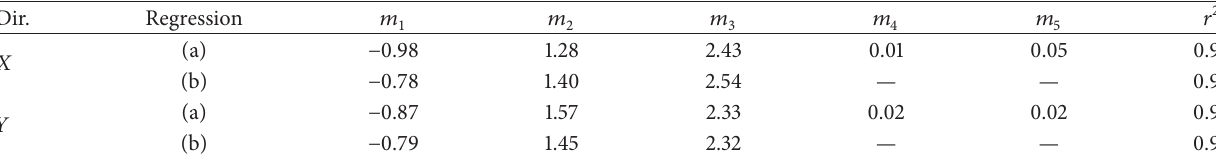
Table 6: Linear regression